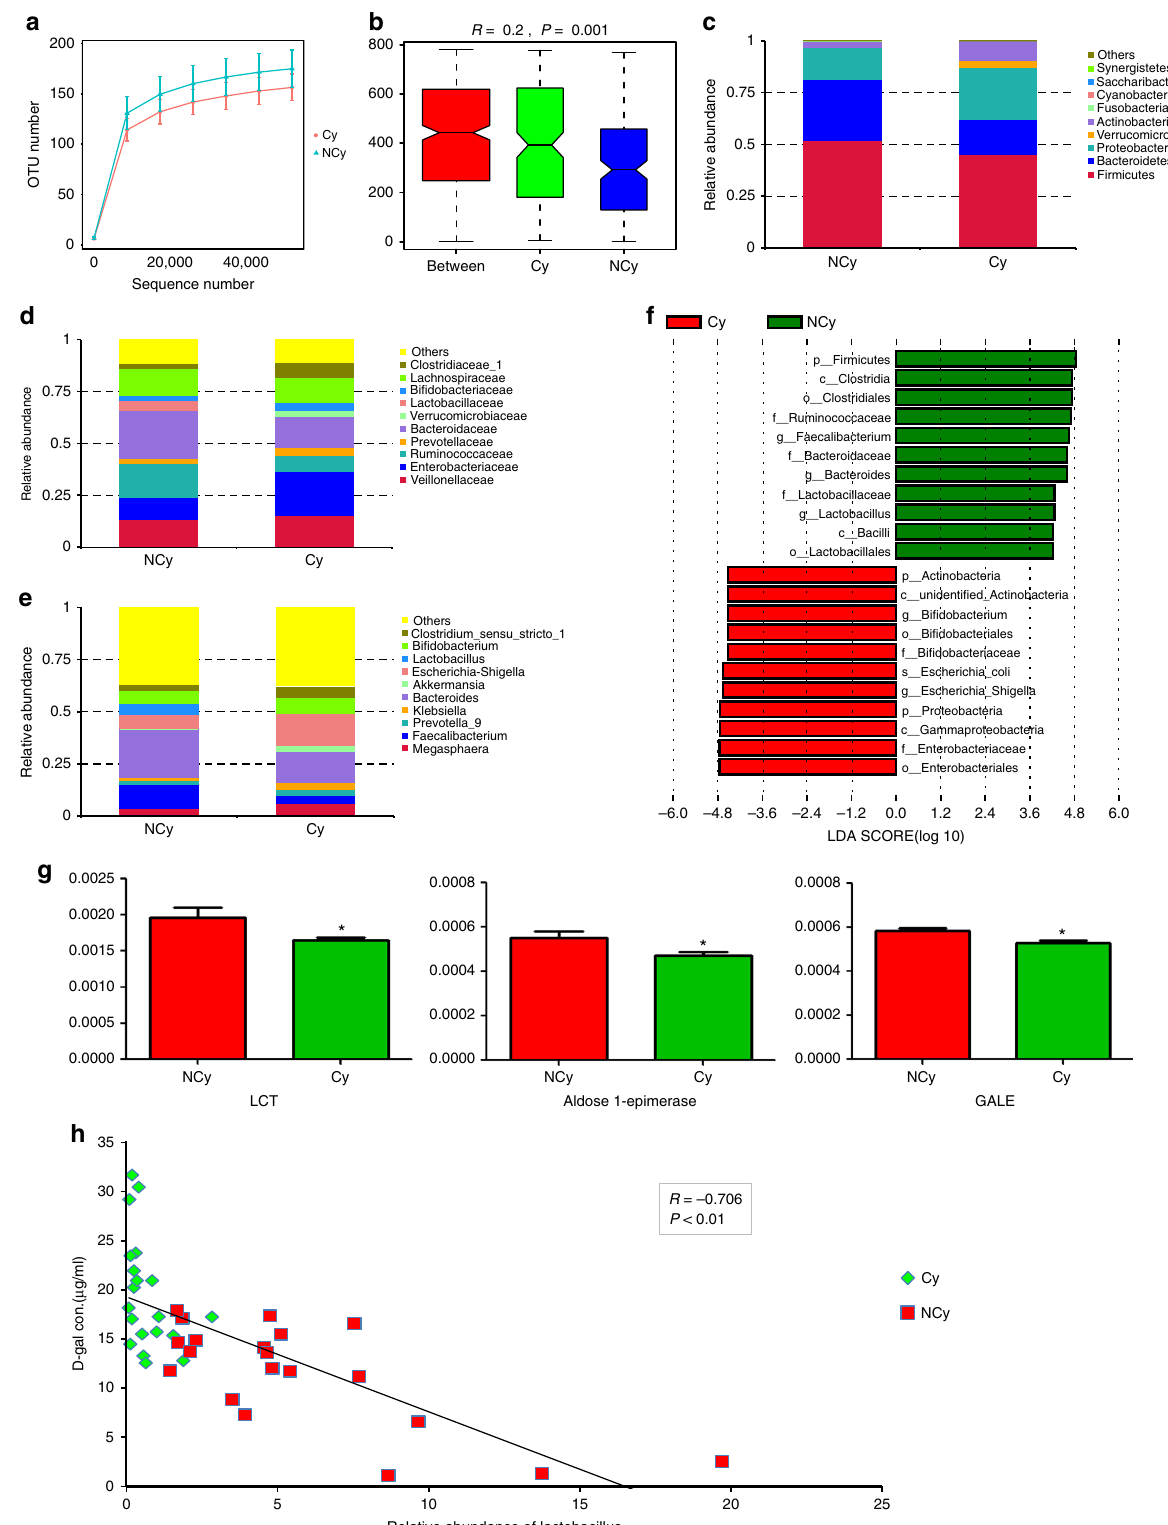
Fig. 4 Profound hypoxia resulted in gut microbiota dysbiosis. a Rarefaction curves of the species number in the NCy and Cy groups ( n = 20 per group). The curve in each group is nearly smooth when the sequencing data set is suf fi ciently large. b ANOSIM analysis of the beta diversity of the samples signi fi cantly separated the groups when R > 0 and P < 0.05. c – e The top 10 relative abundances of bacteria at phylum ( c ), family ( d ) and genus ( e ) levels in faecal samples from the NCy and Cy groups. f LEfSe analysis showed the association between two groups. g Metagenomic sequence analysis of the gene enrichment of enzymes that mediate D -galactose metabolism. LCT ( P = 0.03), aldose 1-epimerase ( P = 0.03), GALE ( P = 0.01). h Pearson correlation analyses of Lactobacillu s in stool and D -galactose in blood (* P <